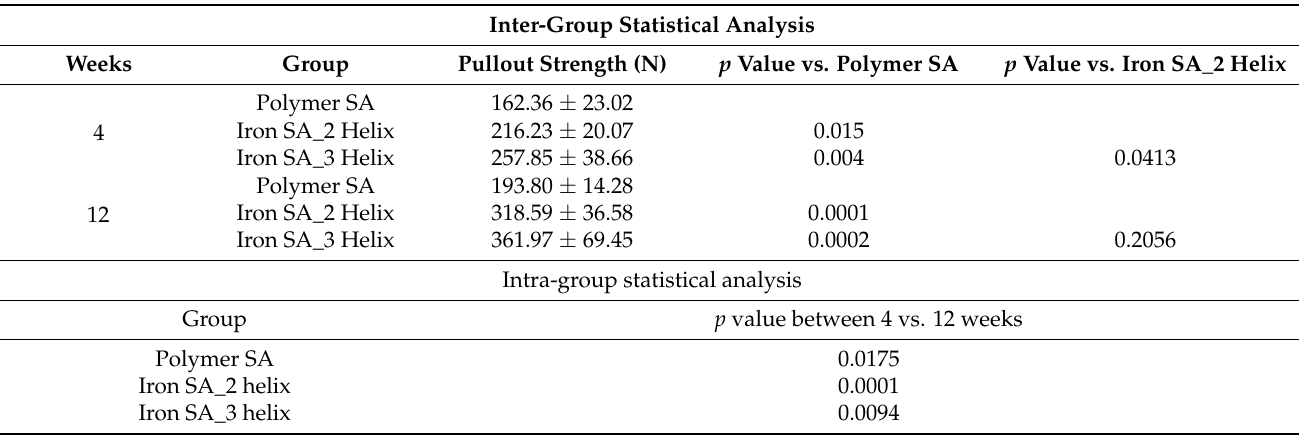
Table 3. In vivo biomechanical ultimate pullout